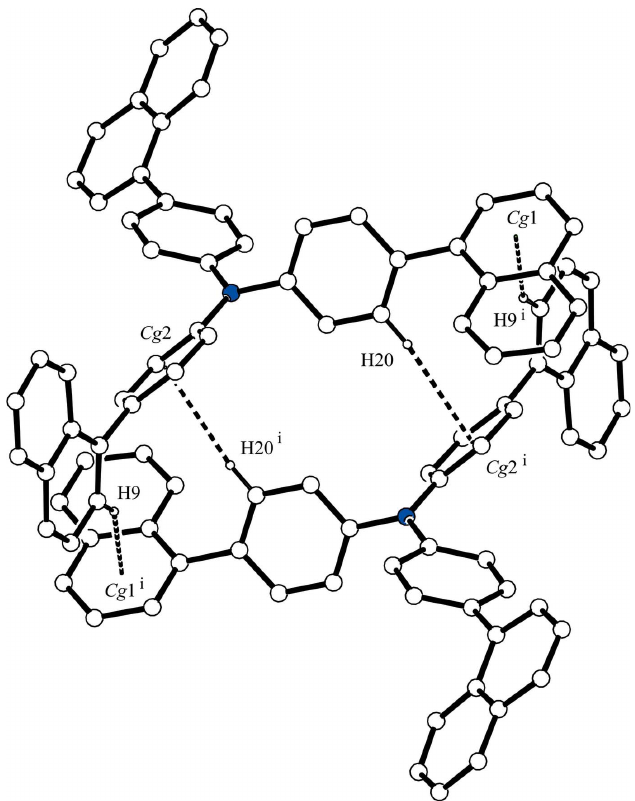
Figure 2 A centrosymmetric dimer of the title compound. The C—H (cid:2)(cid:2)(cid:2) (cid:2) interactions are shown as dashed lines. H atoms not involved in the interactions have been omitted for clarity. [Symmetry code: (i) (cid:3) x + 1, (cid:3) y , (cid:3) z + 2.]